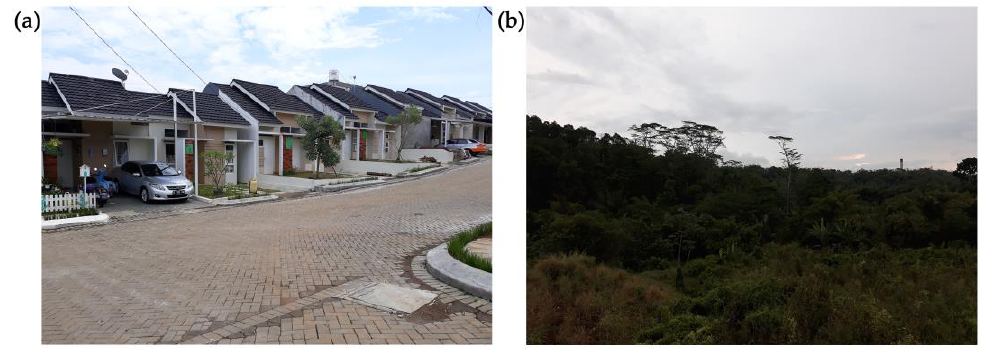
Figure 16. The real condition of high change area ( a ) and no change area ( b ).